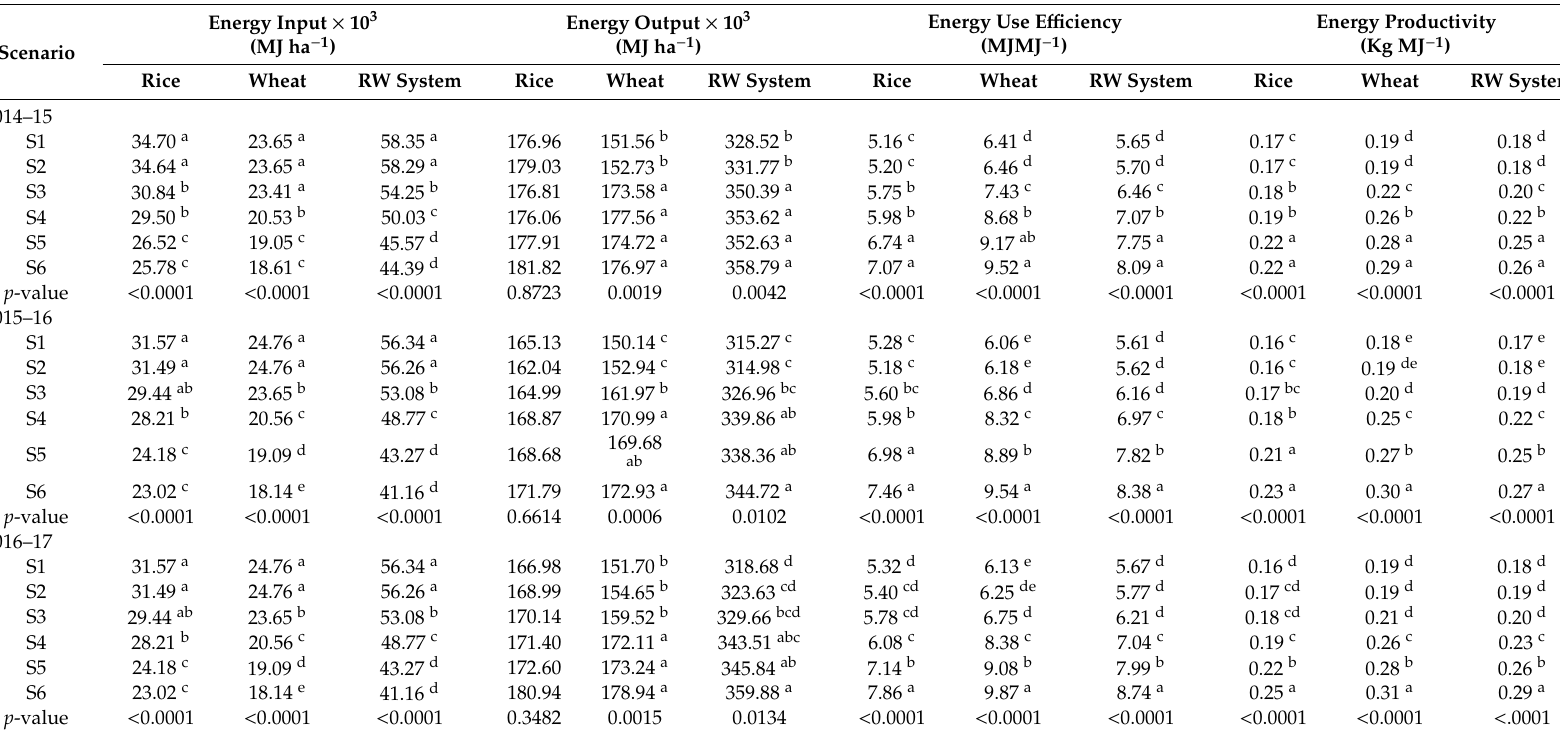
Table 8. E ff ect of di ff erent crop management scenarios on input and output energy, energy use e ffi ciency and energy productivity during a 3-year